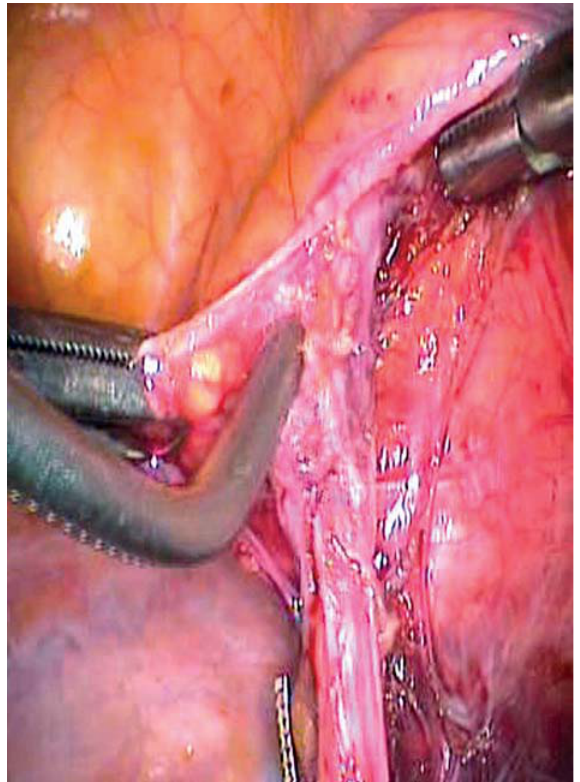
Figure 3 – Operative view of a right ureteral laparoscopic dis- section showing the region of the ureteral stricture.